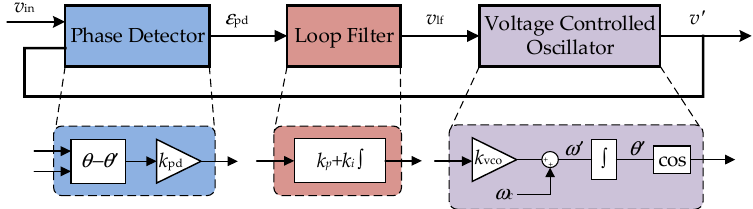
Figure 3. Basic structure of a phase-locked loop (PLL) system.